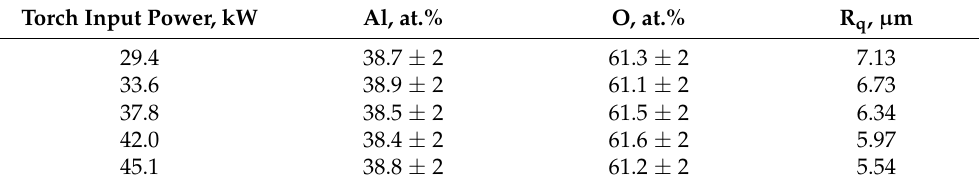
Table 2. Elemental composition and mean square roughness of alumina coatings.